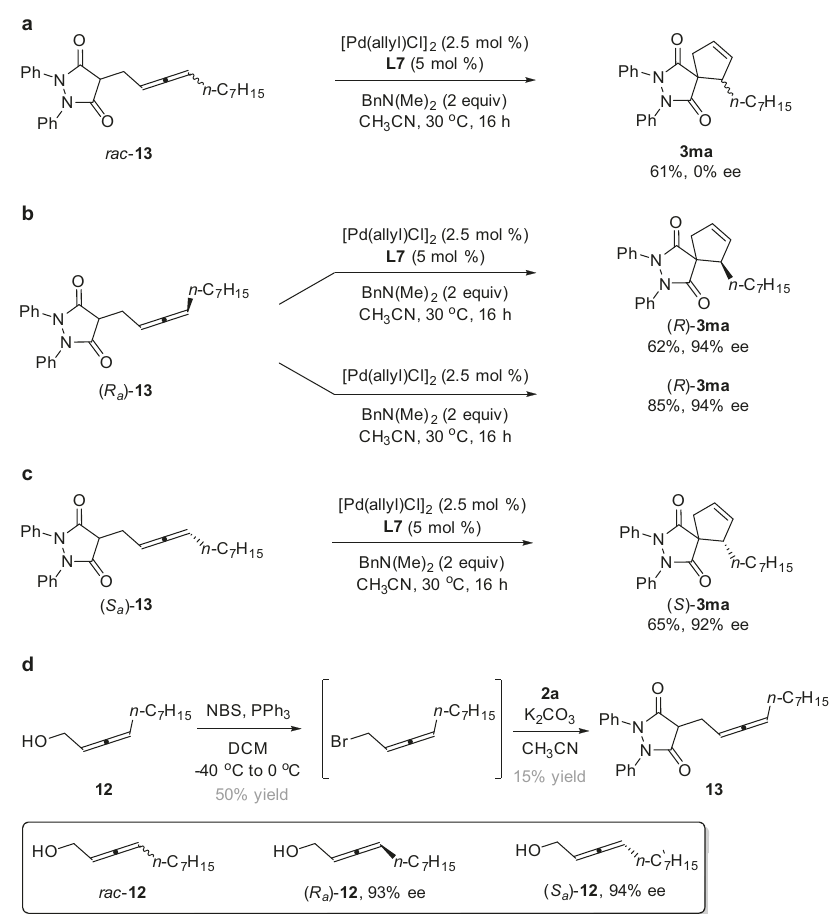
Fig. 6 Mechanistic experiments. a The cyclization of rac- 13 led to the spirocyclic product 3ma with 0% ee. b The cyclization of ( R a )- 13 afforded ( R )- 3ma in 62% yield with 94% ee. c The cyclization of ( S a )- 13 afforded ( S )- 3ma in 65% yield with 92% ee. d The preparation of the allene intermediate 13 from allenyl alcohol 12 . NBS N